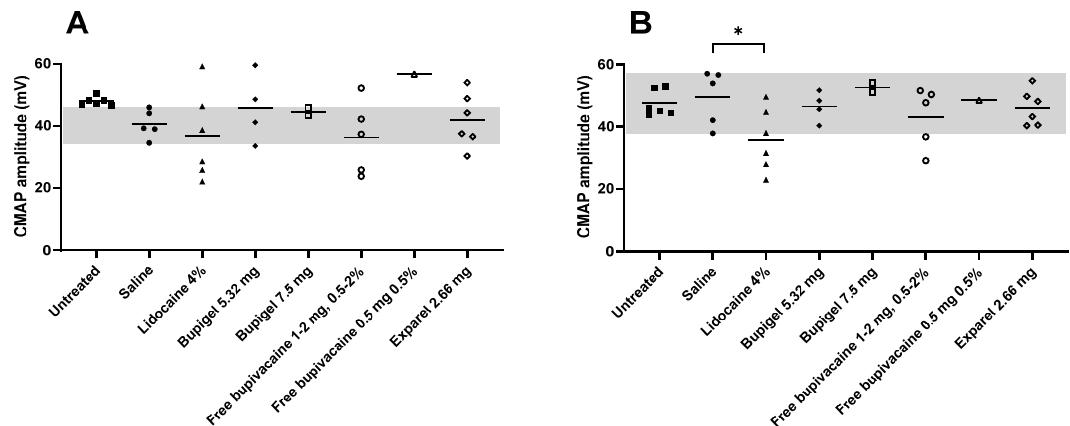
Figure 4. Effect of the different formulations on distal CMAP (compound muscle action potentials) amplitudes. Tibial ( A ) and peroneal ( B ) CMAP amplitudes were measured two weeks after perineurial administration of the different formulations. Gray area in the background indicates the range of values for the saline group. Any value below the saline group’s LLN (gray area) was considered as abnormal (axonal damage). Saline n = 5, lidocaine 4% n = 6, Bupigel 5.32 mg n = 4, Bupigel 7.5 mg n = 2, free bupivacaine 0.5 mg at 0.5% n = 1, free bupivacaine (1–2 mg at 0.5–2%) n = 5 (1 limb per dose and concentration tested), Exparel ® n = 4, untreated/naïve n = 6. * p < 0.05, n = number of legs.